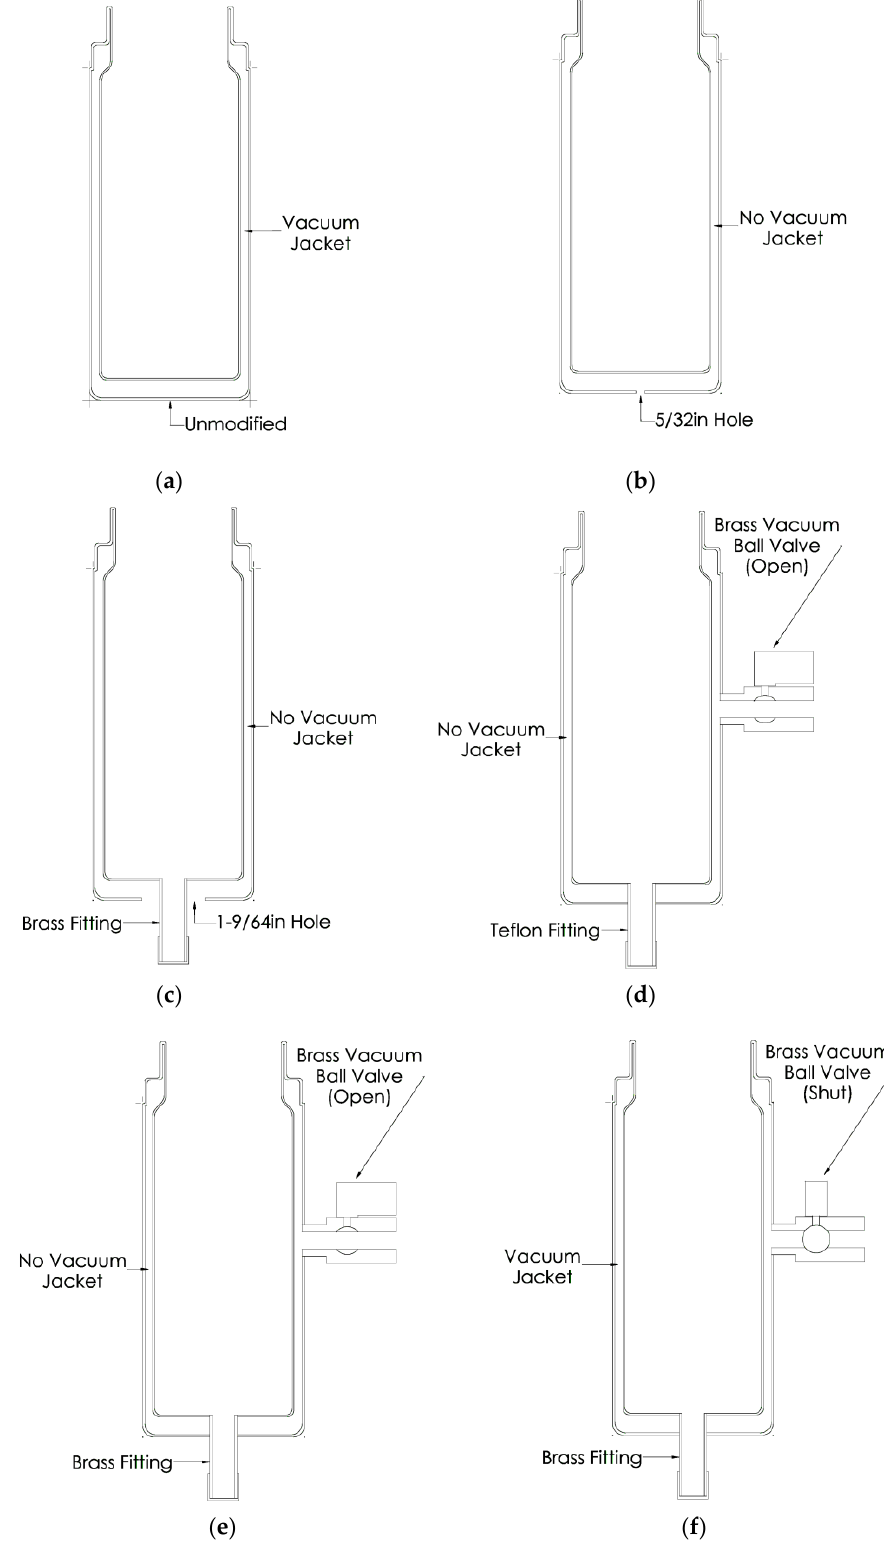
Figure 2. ( a ) Experimental configuration A; ( b ) Experimental configuration B; ( c ) Experimental configuration C; ( d ) Experimental configuration D; ( e ) Experimental configuration E; ( f ) Experi- mental configuration F. A 1/4 in brass barbed hose fitting was attached to the vacuum ball